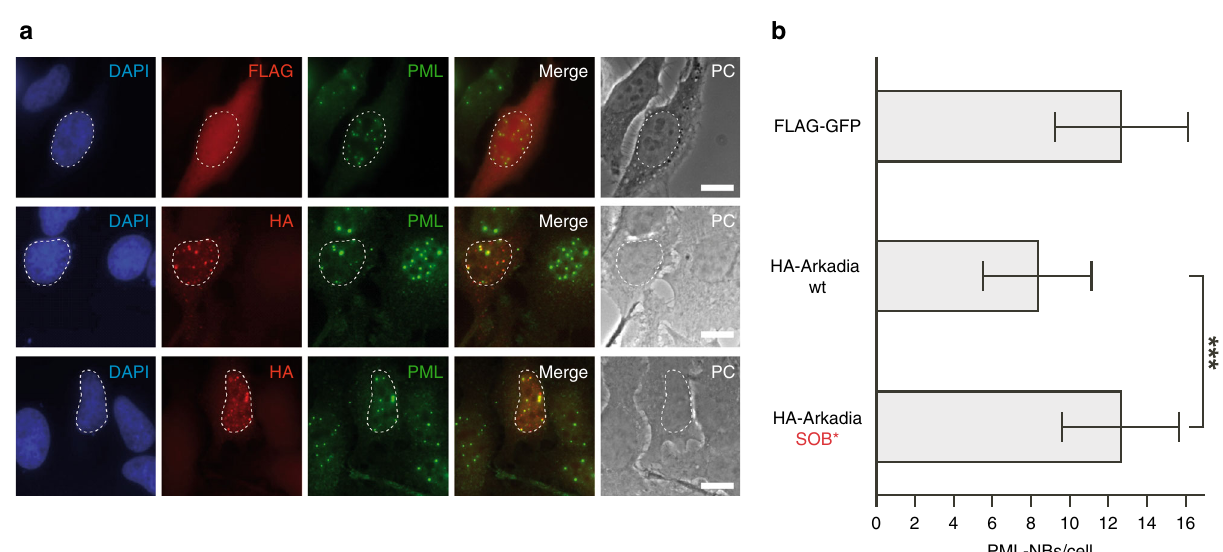
Fig. 5 Arkadia-mediated disruption of PML-NBs requires its SOB motif. a HeLa cells were transiently transfected with plasmids expressing either FLAG- GFP, wild-type (wt) HA-Arkadia, or its SOB mutant version (SOB*). Cells were fi xed, co-stained using mouse anti-FLAG, rabbit anti-PML as well as rat anti- HA antibodies, and analyzed by immuno fl uorescence microscopy. Nuclei were stained with DAPI. Nuclei of transfected cells positive for HA or FLAG staining are highlighted by dashed lines. Scale bar, 10 µ m. b Quantitative analysis of the number of PML-NBs in at least 35 cells from each of the samples shown in a . *** p < 0.001. Bars represent the means. Standard deviations (SD) are indicated by error bars. Statistical signi fi cance was determined with unpaired and two-sided Student ’ s t -tests. Source data for b are provided as a Source Data fi